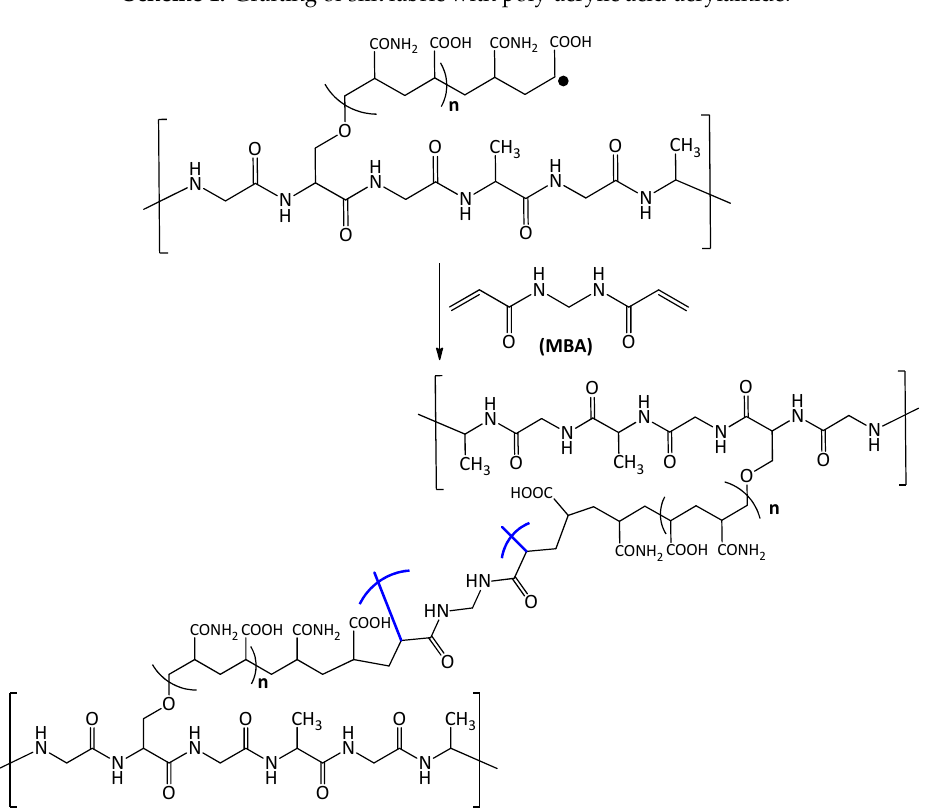
Scheme 2. Crosslinking of poly-acrylic acid-acrylamide chains using MBA.